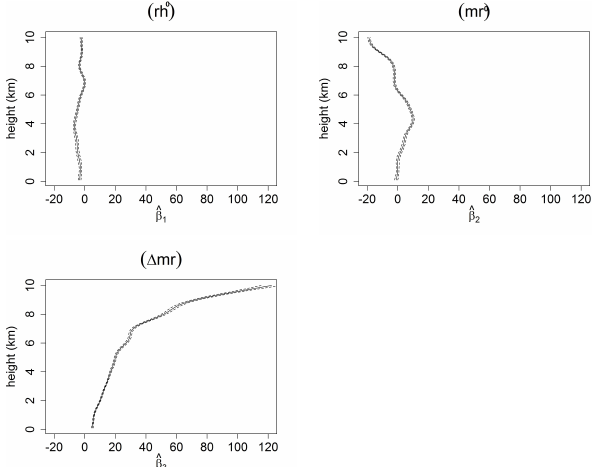
Fig. 8. Squareroot total uncertainty (cid:0) σ ∆ y (cid:1) budget for relative humidity collocation mismatch, including: Natural variability (cid:0) σ ∆ µ (cid:1) , mea- surement error ( σ ε ) , sampling error ( σ β = β 0 ) . 0